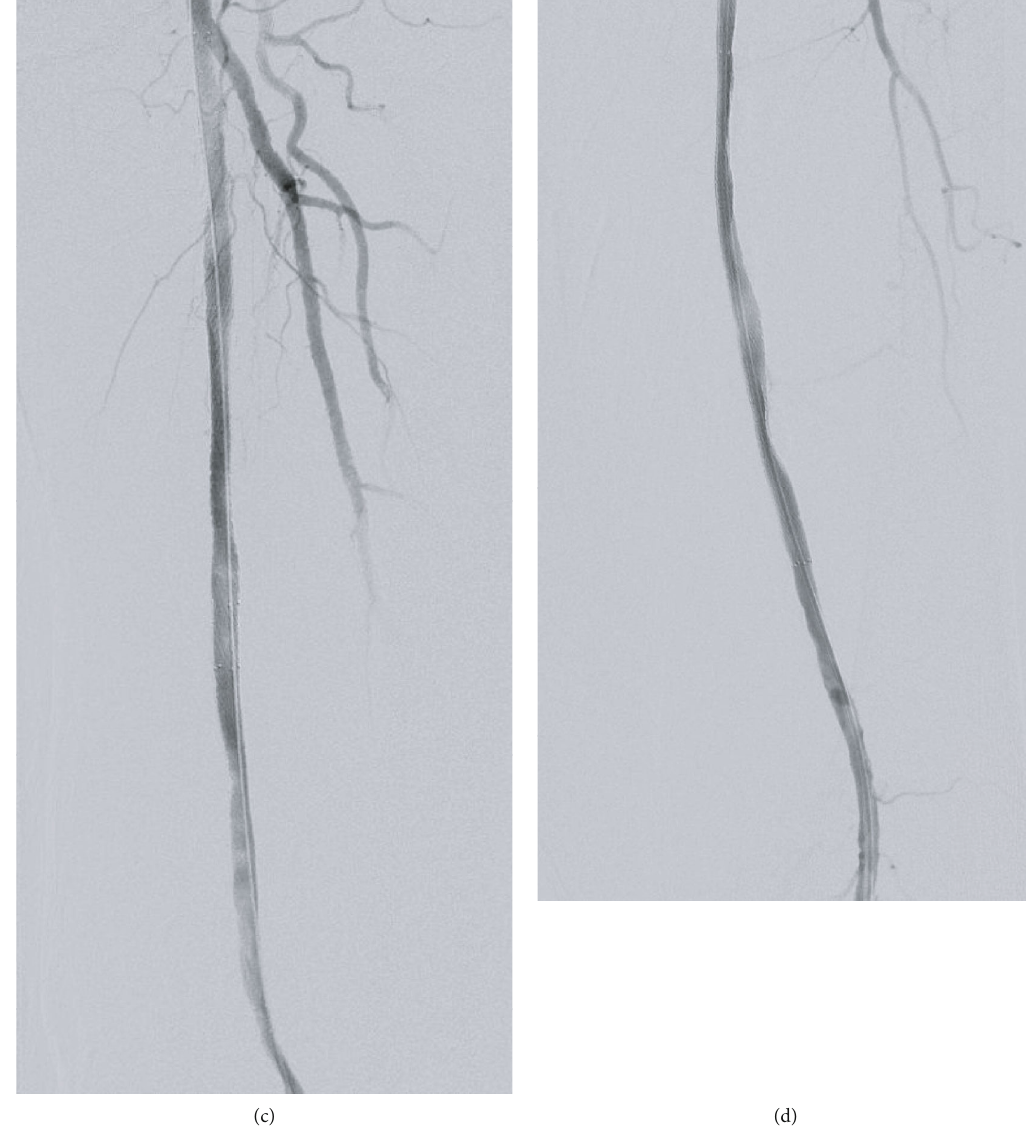
Figure 1: (a, b) Prerecanalization; (c, d)